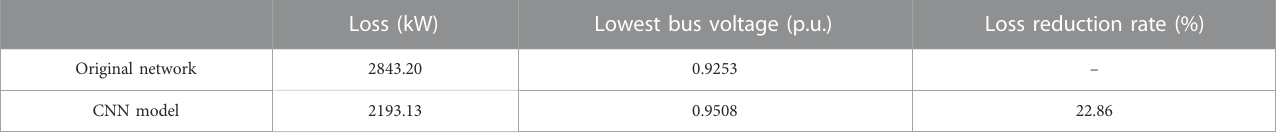
TABLE 9 185 bus system program running time